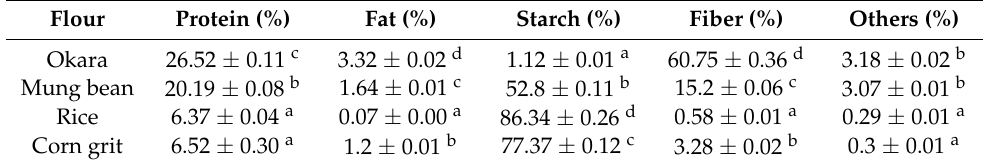
Table 3. Proximate composition of